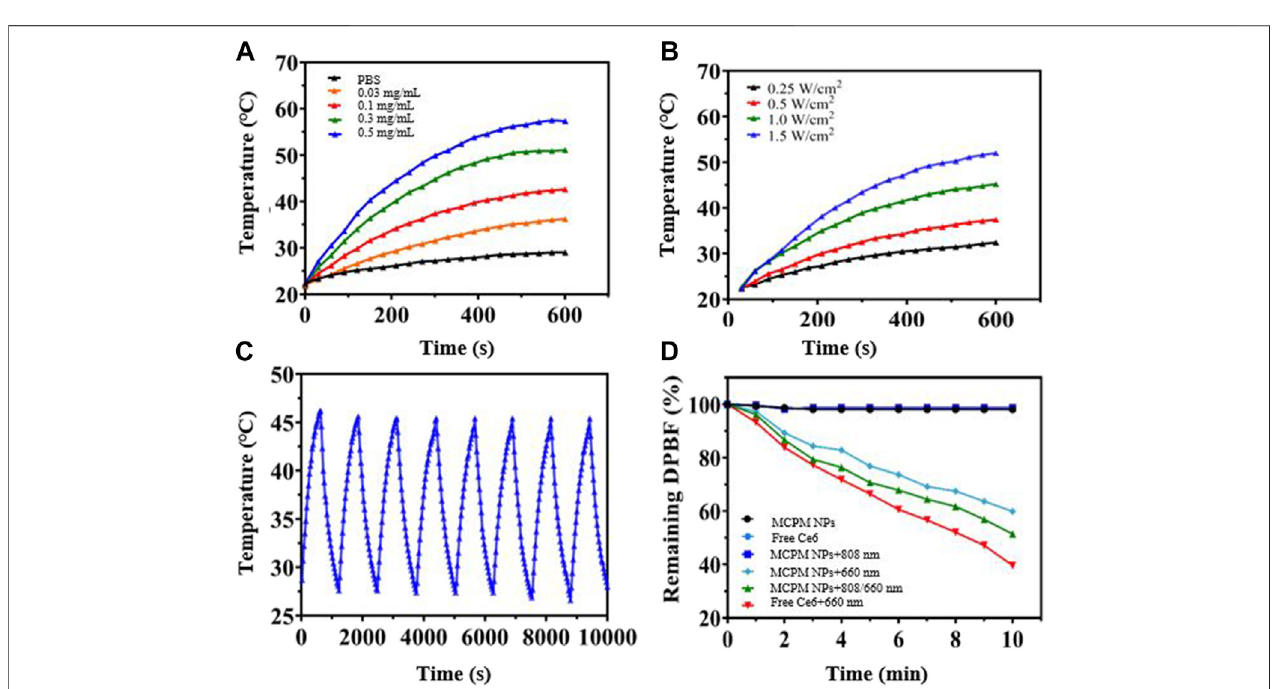
FIGURE3 | Photothermal and singlet oxygen generation performanceof MCPM NPs. (A) Temperature curvesat different concentrationsof MCPM NPs irradiated under 1.0 W cm − 2 . (B) Temperature curves of MCPM NP solution under 808-nm laser irradiation with different powers. (C) Heating and cooling curves of MCPM NPs irradiated by a 1.0-W/cm 2 808 nm laser over eight ON/OFF cycles. (D) Singlet oxygen generation of nanoparticles under laser irradiation. little difference ( Supplementary Figure S3 ). As depicted in manner. At the end of a 10-min exposure to the 808-nm laser Figure 3A ; Supplementary Figure S5 , MCPM NPs were (1.0 W cm − 2 ), the MCPM NP dispersion of 0.03 – 0.5 mg ml − 1 was quickly heated to 36.2 ° C – 57.3 ° C from ambient temperature. In rapidly heated to a threshold in a concentration-dependent